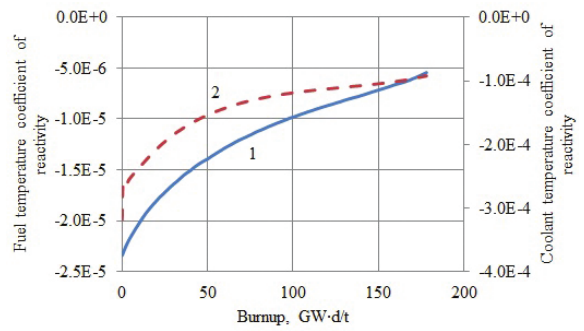
Figure 6. Changes in the reactivity coefficients for the fuel com- position containing 16% of 235 U + 74% of 238 U + 10% of 231 Ра during the campaign: 1) fuel temperature coefficient of reactivi- ty; 2) coolant temperature coefficient of reactivity.